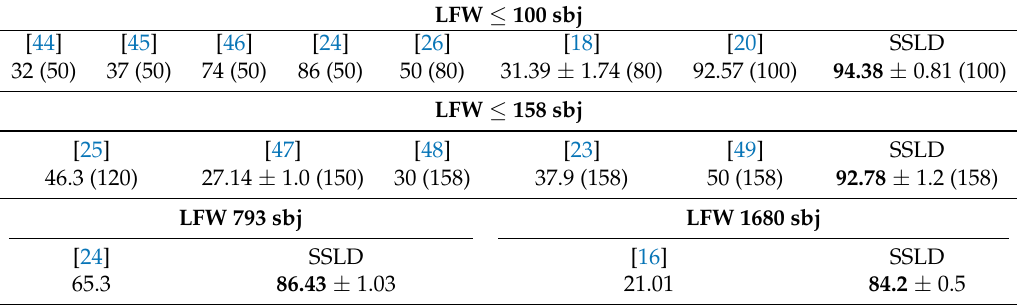
Table 1. Percentages of recognition rate on the LFW dataset, varying the gallery cardinality. For comparison, we report the SSPP state of the art on the LFW. Standard deviation is reported when available. We summarize in a common row results obtaining referring to galleries with slight dimension changes, while precising in brackets the real gallery cardinality. In bold we emphasize the best performance per category.